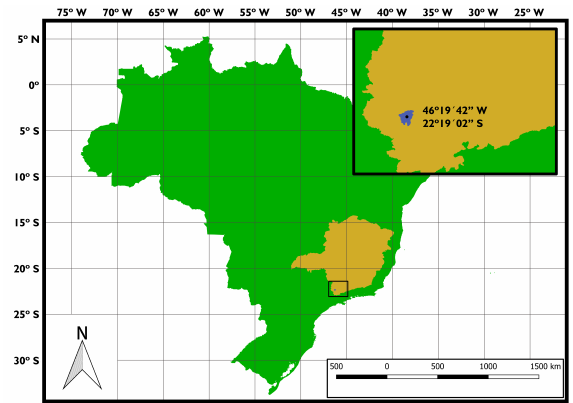
Figure 1. Study area -